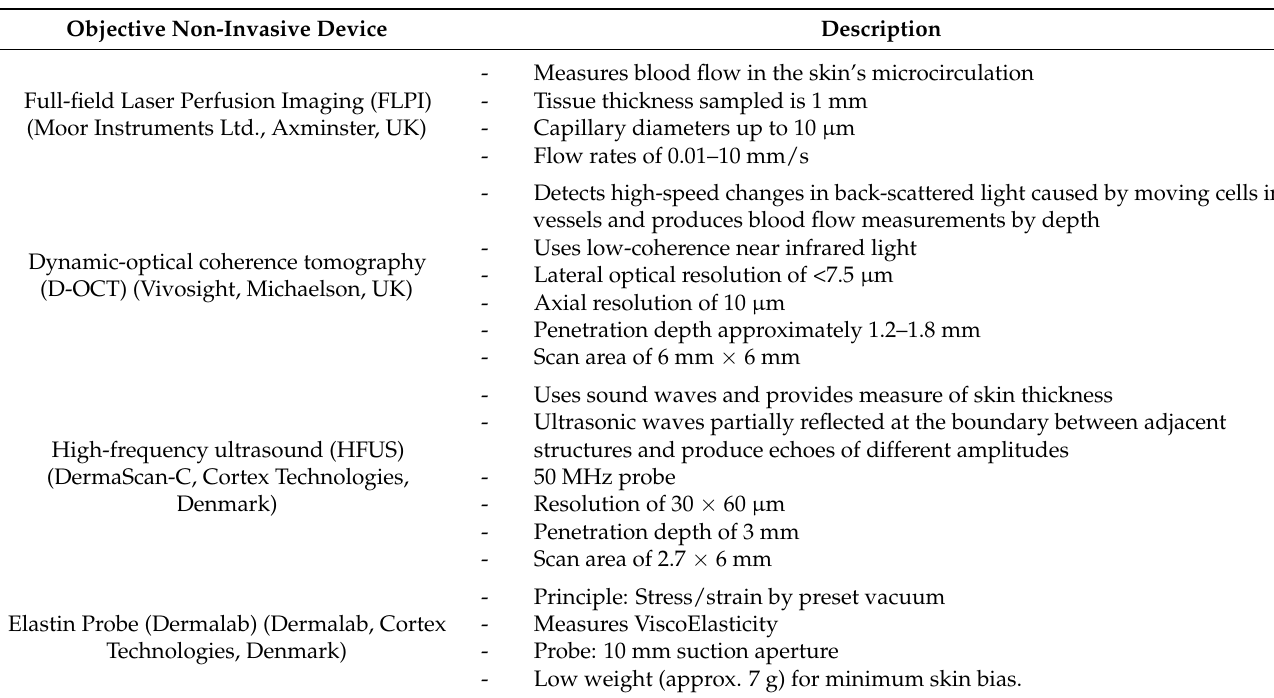
Table 2. Objective non-invasive device modalities which were used at each weekly time point over 8 weeks during this study to monitor the progression of healing.